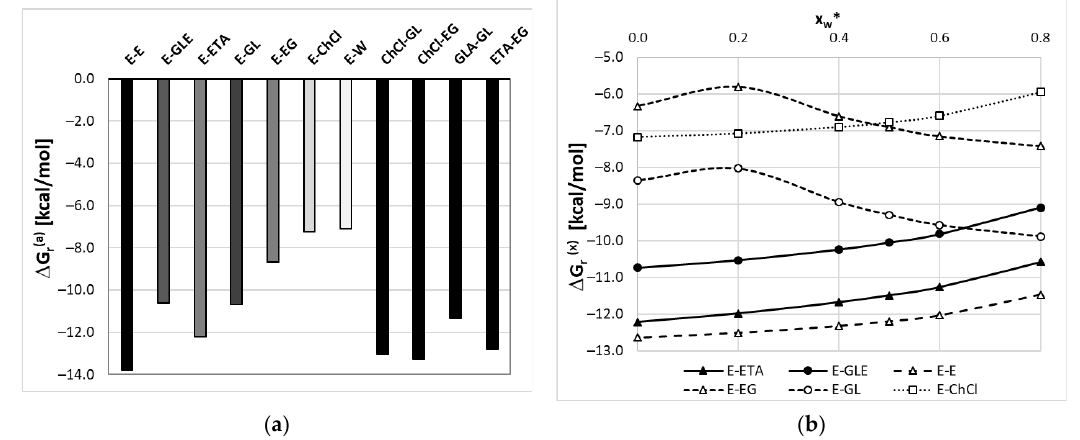
Figure 8. The values of edaravone affinity expressed as ( a ) activity-based Gibbs free energy ( ∆ G r(a) = − RTln(K a ); K a = K x ·K γ ) and ( b ) concentration-dependent values of Gibbs free energies ( ∆ G r(x) (x) = −RTln(K x ) in ethaline or glyceline (T = 298.15 K, ETA = ChCl:EG = 1:2, GLE = ChCl:GL = 1:2), where x w * denotes water mole fraction in solute-free solution. The following notation of intermolecular complexes was used: edaravone dimer (E-E), E pairs with glyceline ion pair (E-GLE), ethaline ion pair (E-ETA), glycerol (E-GL), ethylene glycol (E-EG), choline chloride (E-ChCl), and water (E-W).